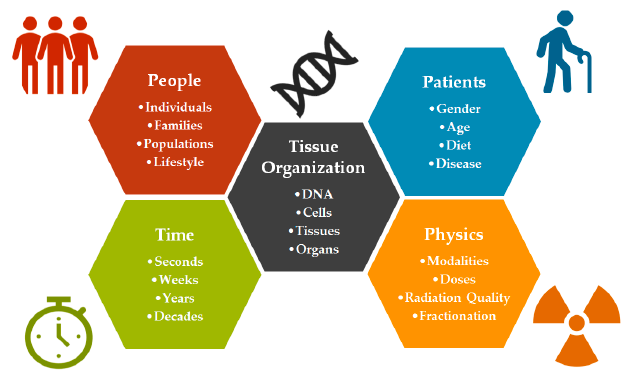
Figure 1. The multi-dimensional problem of radiosensitivity. Radiosensitivity exists across multiple scales of people and time, contributing to the difficulties in predicting who will be sensitive to toxic and carcinogenic effects of radiotherapy in advance.